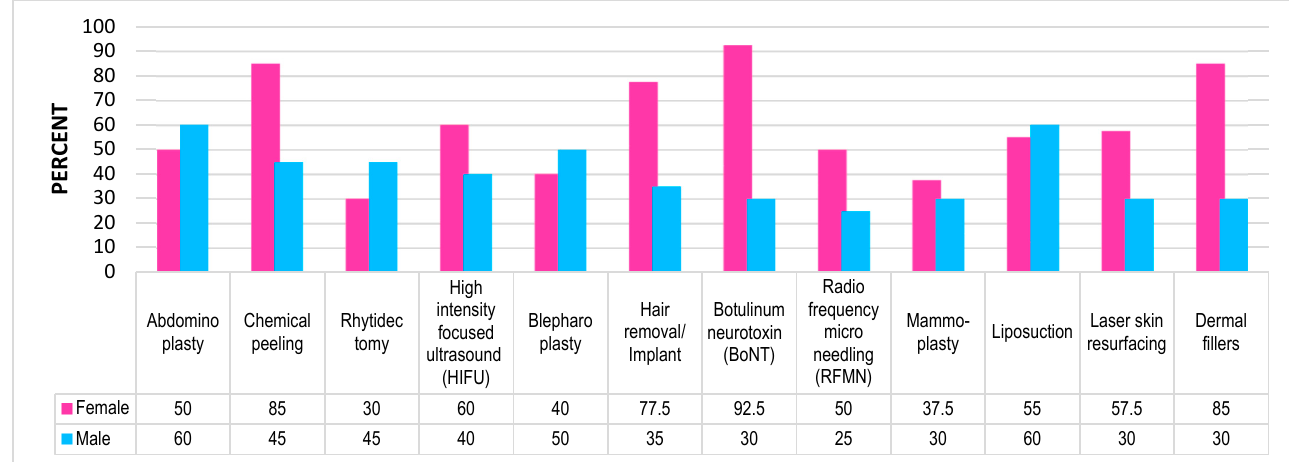
Figure 3. Awareness levels of participants prior to treatment.